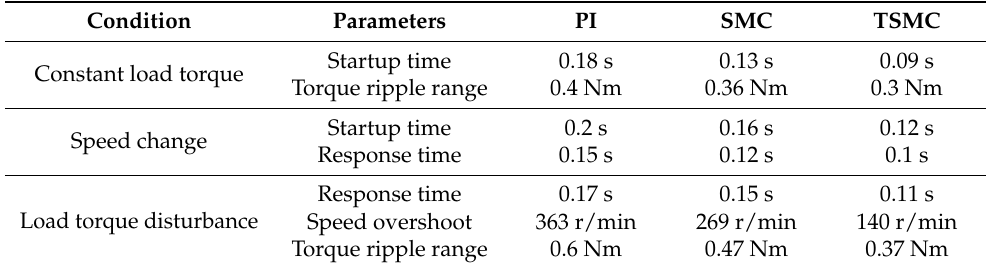
Table 3. Experimental results of three controllers.